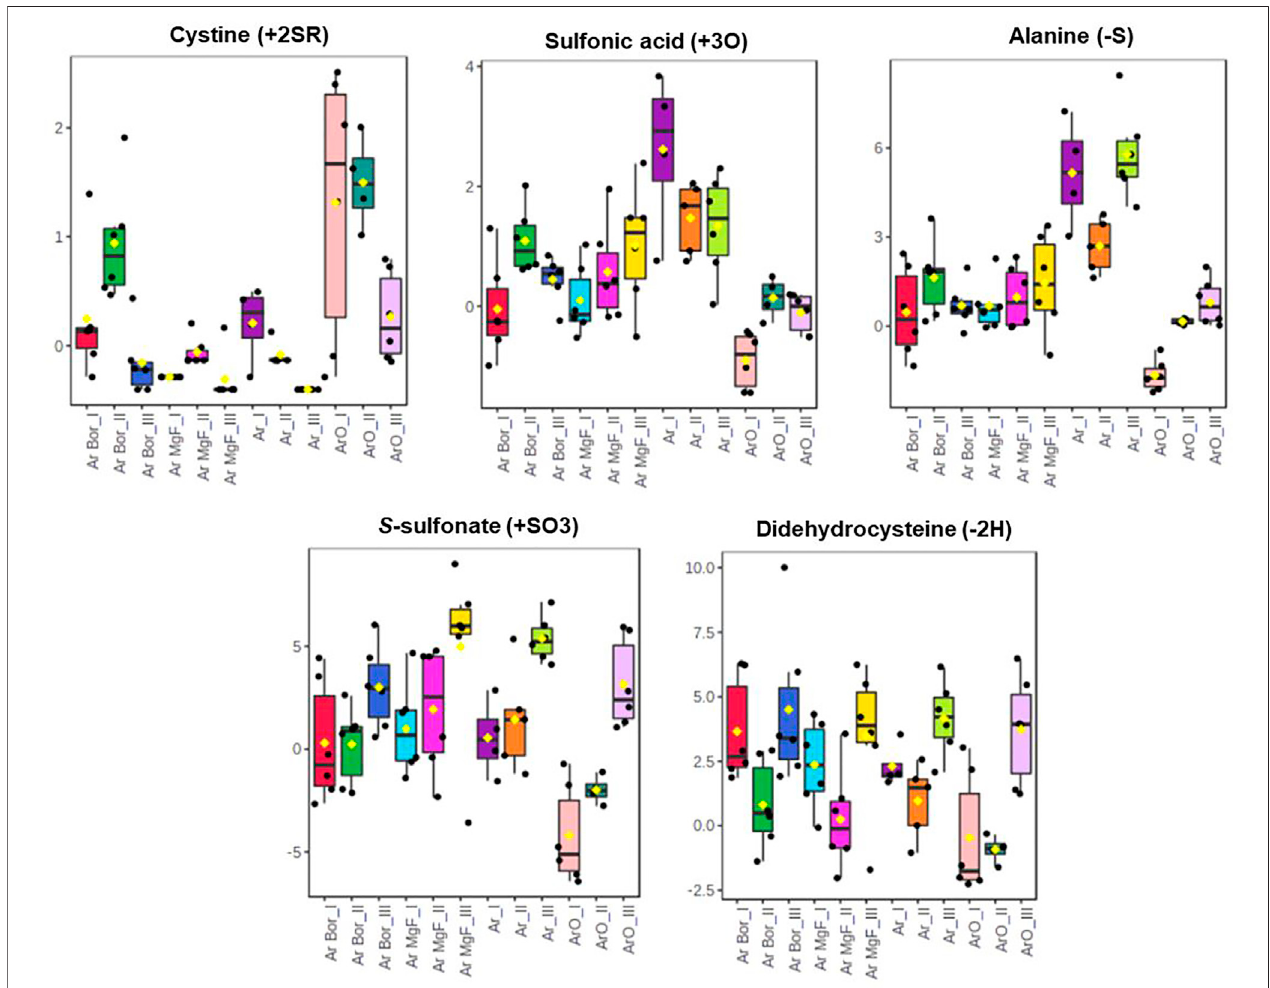
FIGURE 8 | Major oxidative modi fi cations induced in cysteine residues of porcine epidermis proteins. While overall introduction of modi fi cations remain low, free plasma treatment is more effective than VUV treatment (MgF 2 window) or UVB (boro fl oat window, Bor). Layer I is more affected than layers II/III, indicating a limited penetration of reactive species/VUV radiation. See text. Plasma treatments for 1 min cm − 2 , using a 3 slm Ar ± O 2 and 5 slm N 2 shielding gas. Experiment performed in triplicates. Percentage of modi fi ed cysteines shown. Modi fi cation selected by ANOVA, p -value < 0.05.